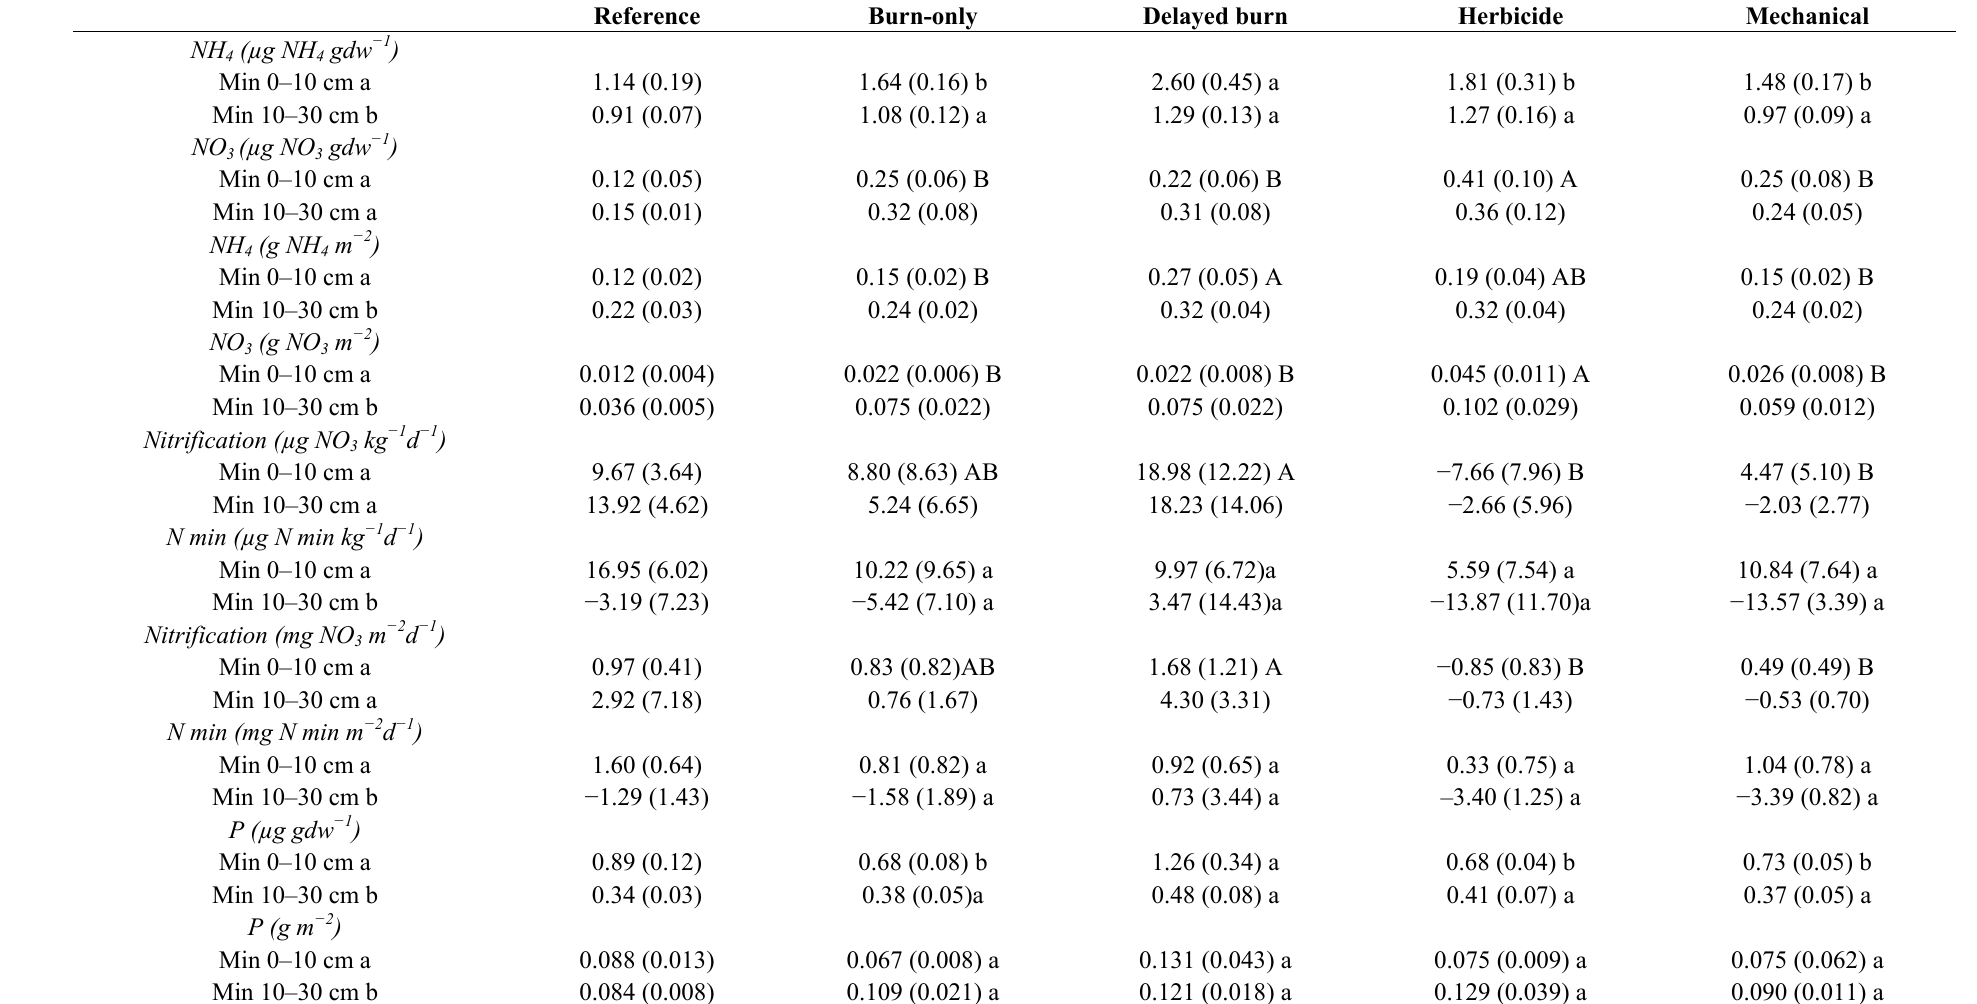
Table 5. Means and standard errors of inorganic N and N mineralization, and P for reference (not included in the GLMM testing) and restoration plots in longleaf pine forests at EAFB, Florida for summer 2009. Means for treatment and depth with the same letter (capital letter was used when the two soil horizons were combined) do not differ at p <